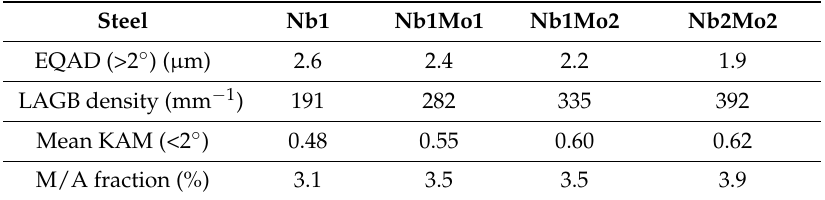
Table 3. As-quenched microstructure features as determined by EBSD